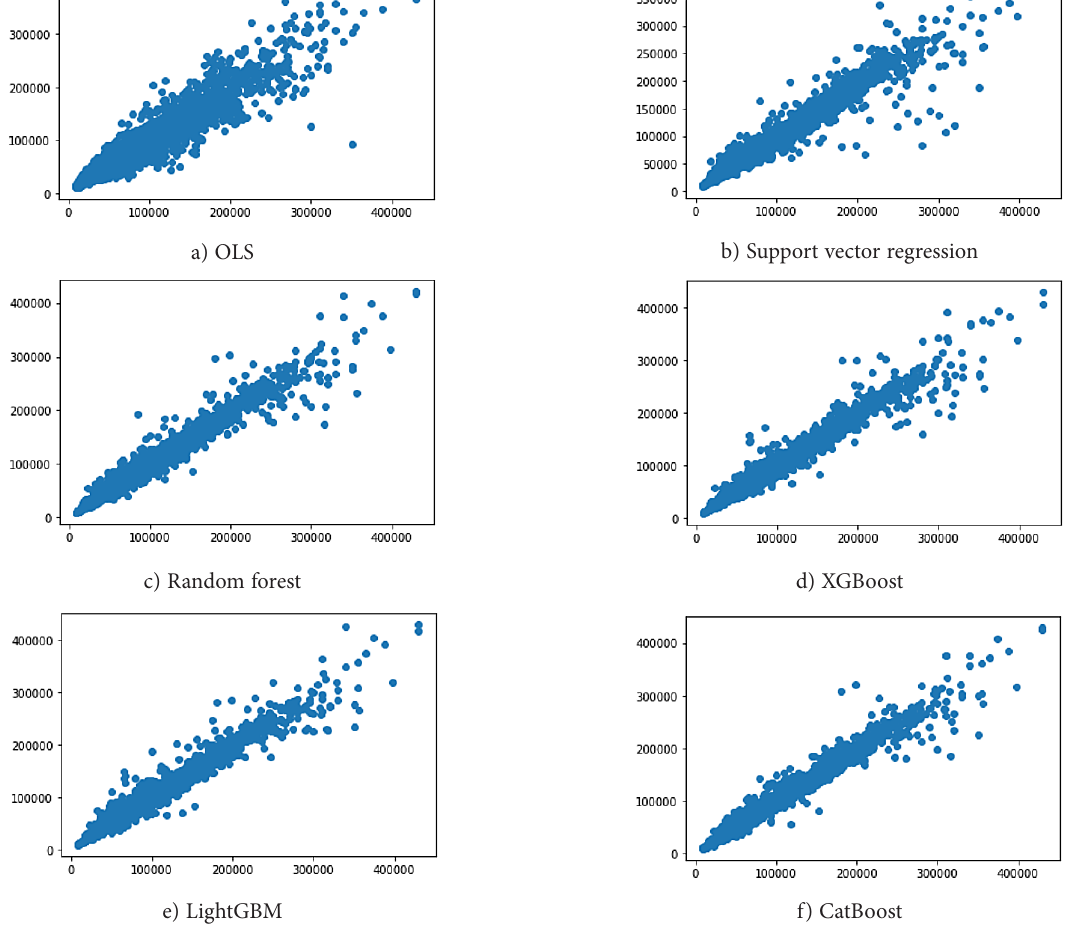
Figure 7. Scatter plots of the actual contract prices (depicted on the horizontal axis) and the predicted values (shown on the vertical axis) of the